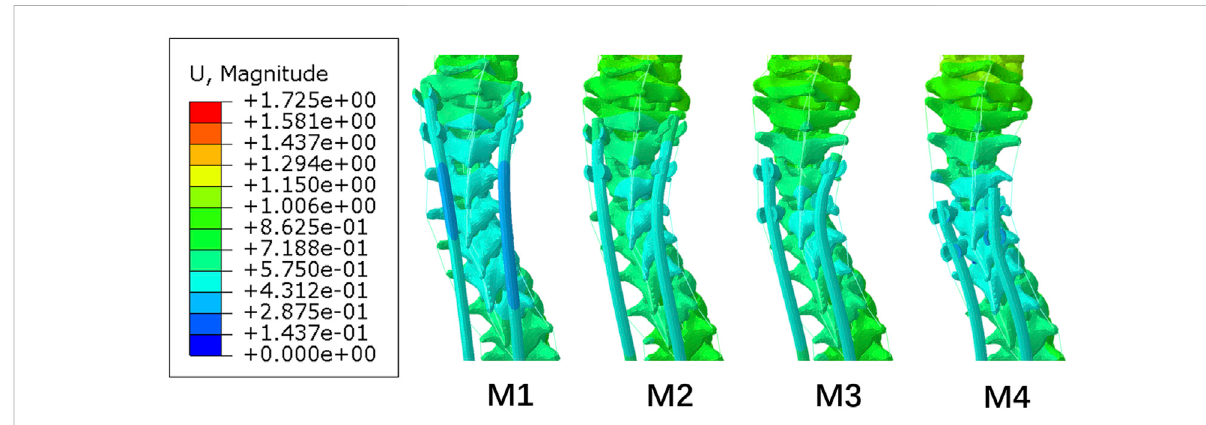
FIGURE 7 Displacement nephogram of posterior proximal of M1 − M4.